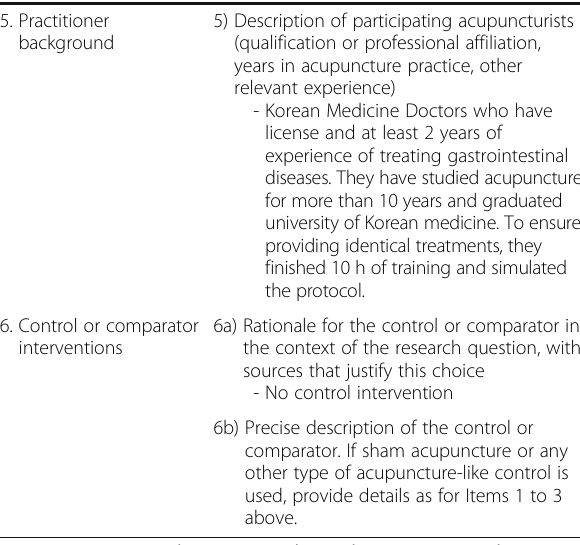
Table 2 Acupuncture treatment details based on the STRICTA (Macpherson H et al., [12]) checklist